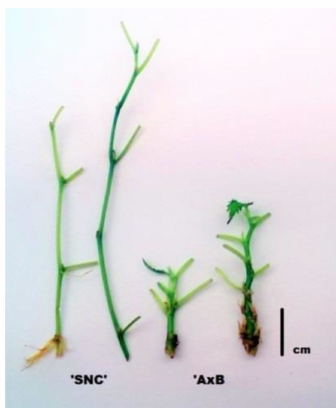
Figure 2. Morphological di ff erences of shoots obtained from “SNC” and “AxB” cultures of mountain mulberry ‘Kenmochi’. The bar is 1 cm long.